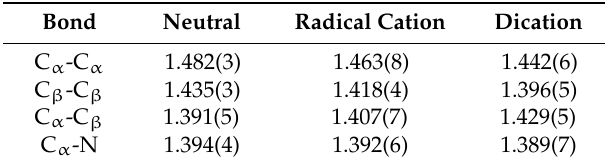
Table 1. Selected bond lengths of 2a , 2a • + [PF 6 − ], and 2a 2 + [PF 6 − ] 2 (the bonds in nitro-substituted pyrrole moiety were omitted due to the disorder) [Å] 1